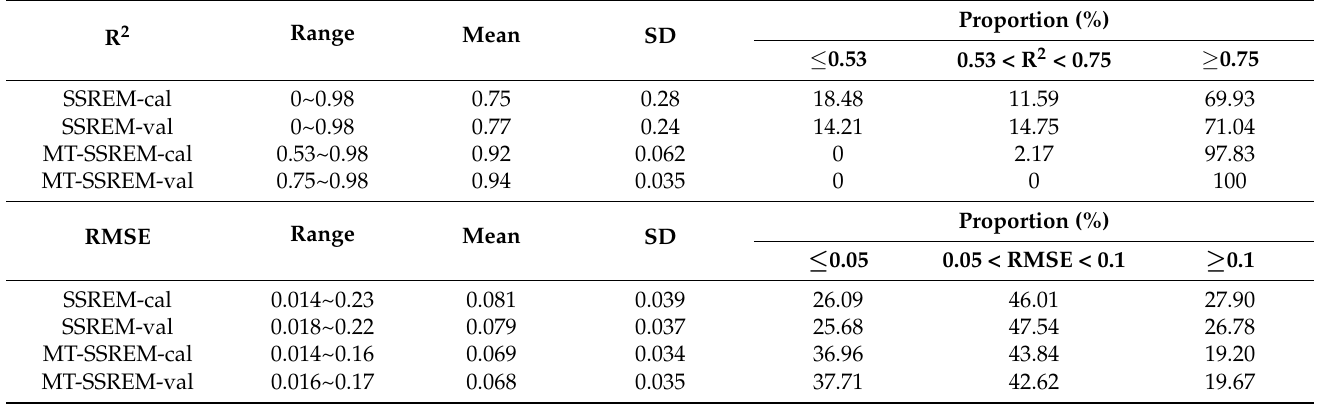
Table 3. Statistics of R 2 and RMSE for SSREM and